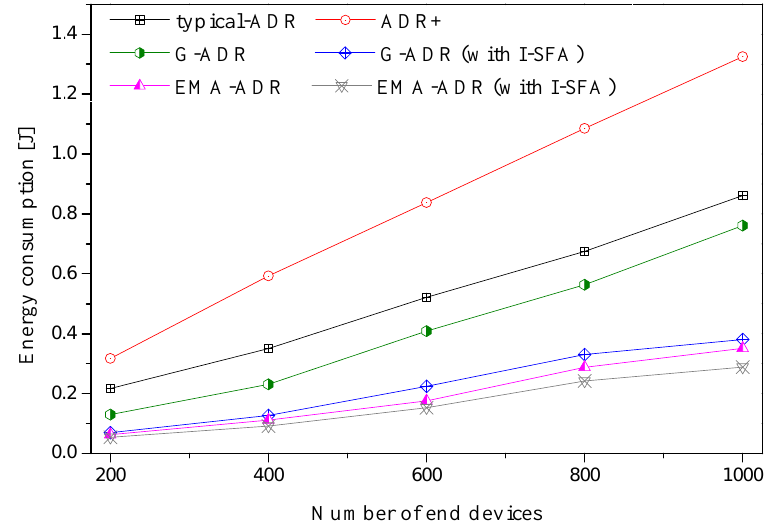
Figure 12. Average energy consumption for static EDs (uplink period = 24 packets/day, total simulation time = 4